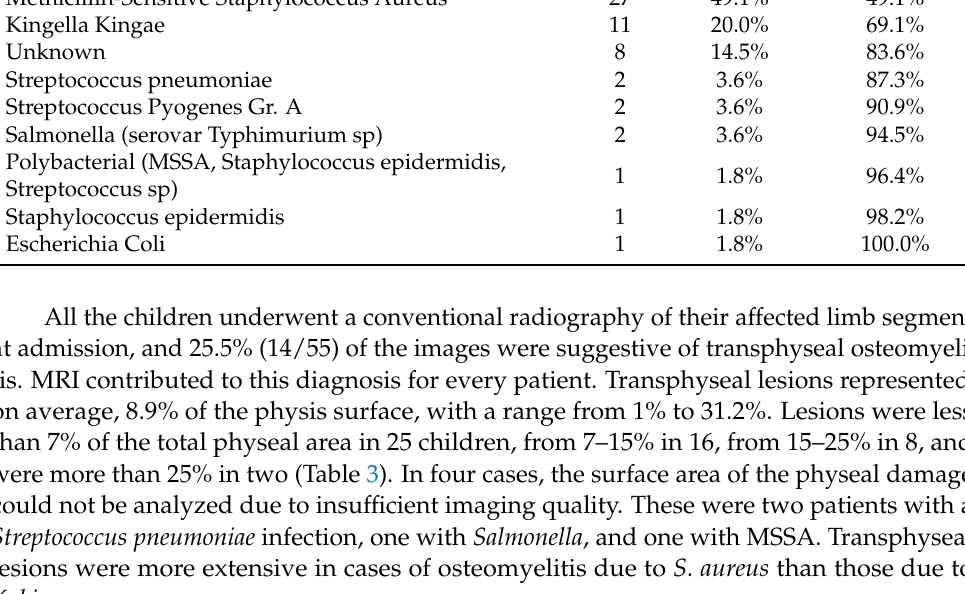
Table 3. Distribution of physeal involvement relative to the total surface area of growing